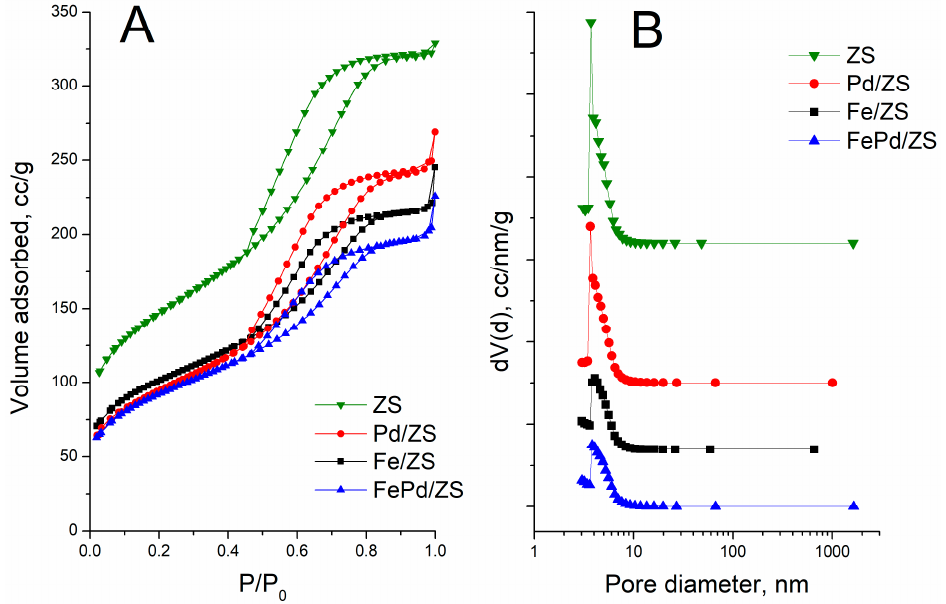
Figure 1. Nitrogen physisorption isotherms ( A ) and pore size distributions ( B ) for unreduced catalysts.